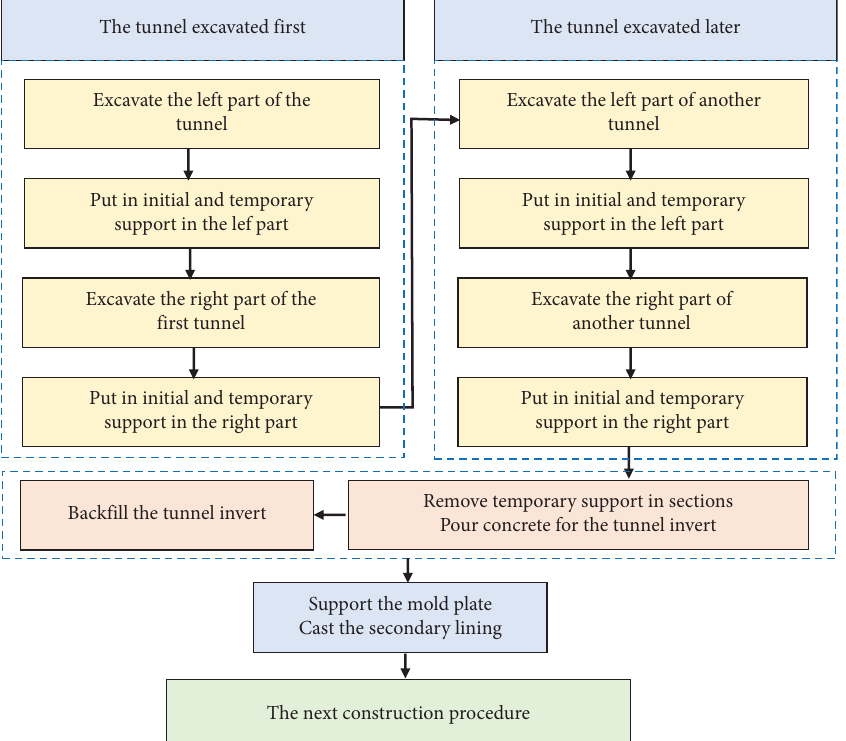
Figure 3: Te construction process fow chart of CD method.